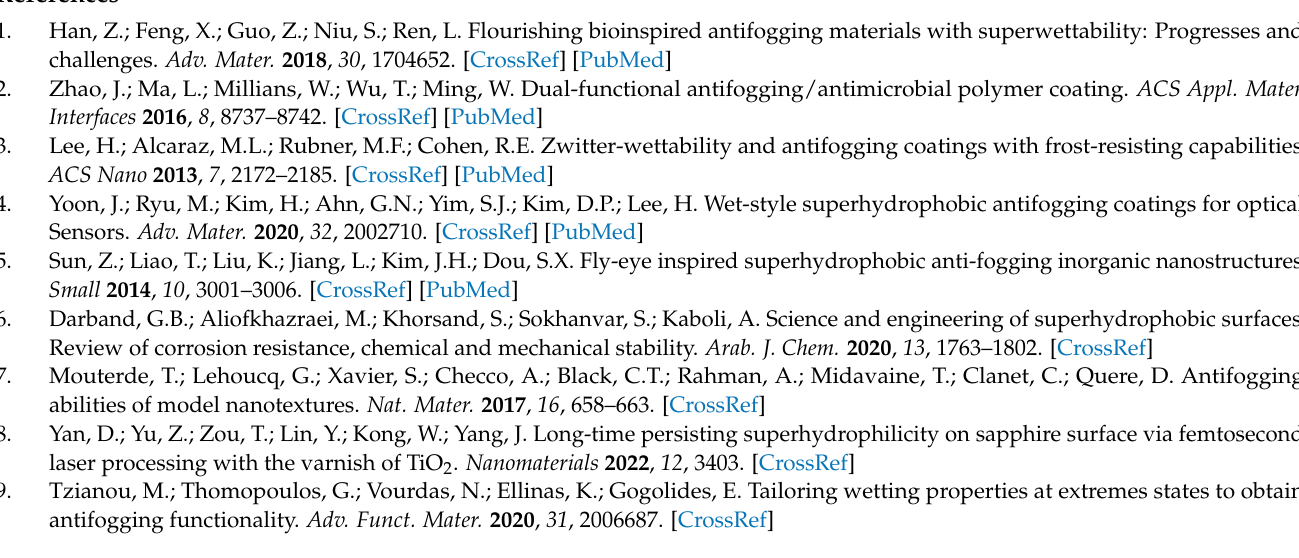
Figure S5: FTIR spectrum of (a) PUA; (b) PAHS; Figure S6: SEM image of BPs; Figure S7: Cross- sectional SEM image of PUA/PAHS/BPs HN; Figure S8: AFM image of PUA/PAHS/BPs HN; Figure S9: FTIR spectrum of (a) PUA/PAHS HN; (b) PUA/PAHS/BPs HN; Figure S10: XPS spectrum of PUA/PAHS/BPs HN; Figure S11: Transmission spectra of PUA/PAHS/BPs HN with (a) 0–6 wt% BPs; (b) 8–18 wt% BPs; Figure S12: Transmission spectra of PUA/PAHS/BPs HN during high and low temperature